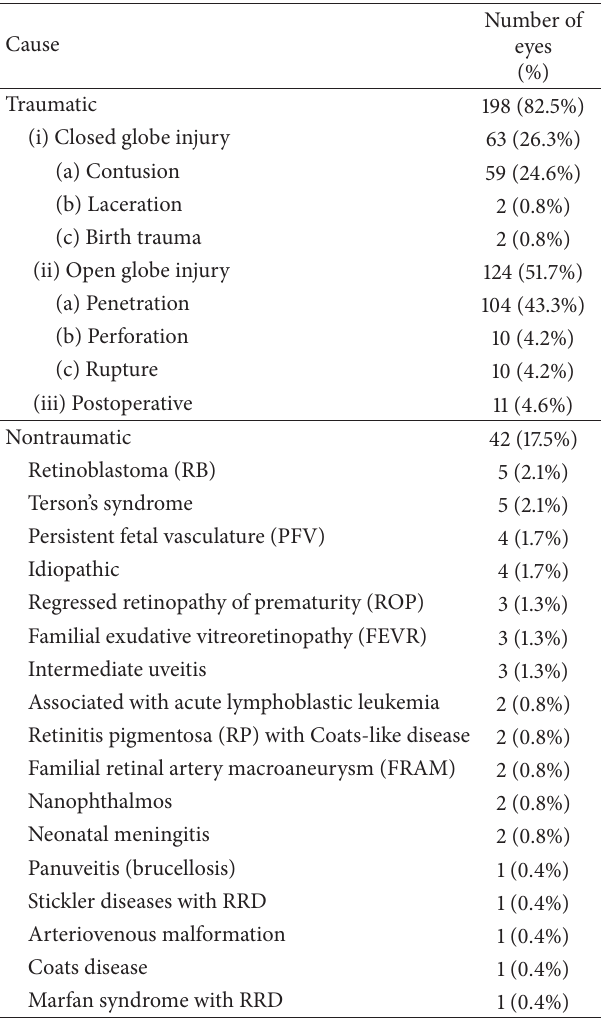
Table 1: Causes of vitreous hemorrhage. Cause